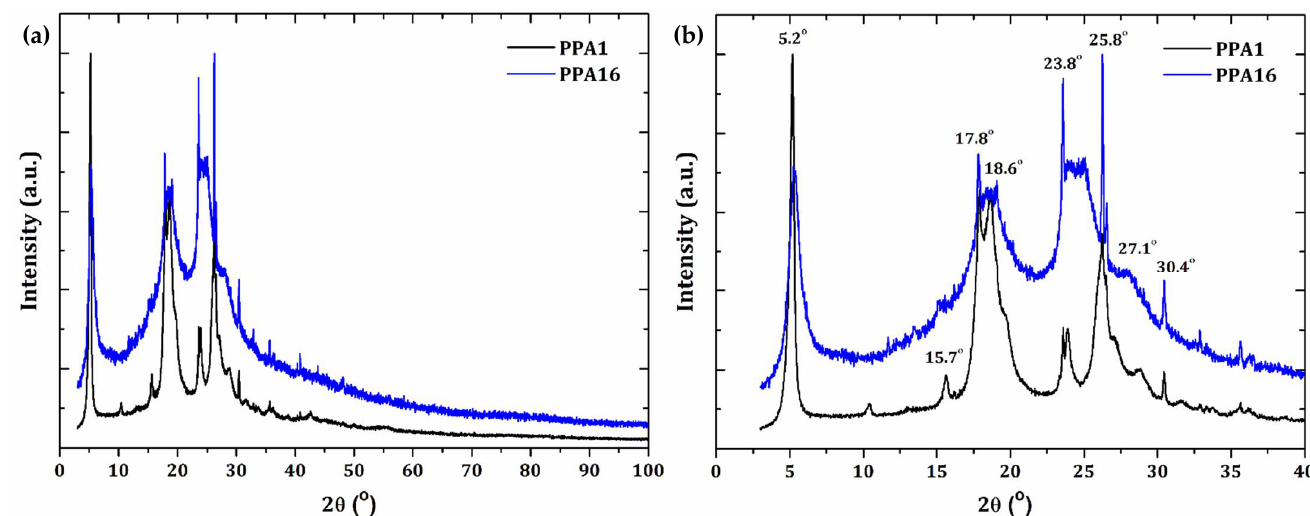
Figure 1. Semicrystalline XRD patterns of the ( a ) as -synthesized PPA1 and PPA16 and ( b ) the angular region 2θ = 3–40° highlighting the most intense diffraction peak positions.